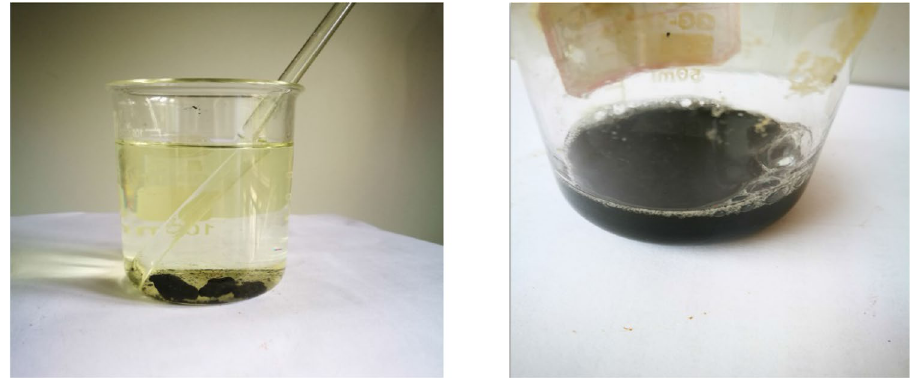
Fig. 9 Dissolution experiment results of the organic-based blockage samples in two types of acid